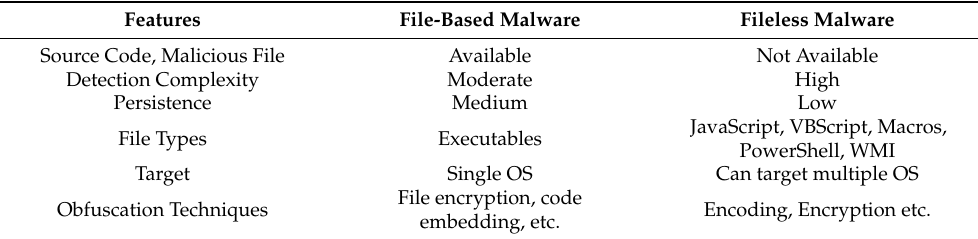
Table 2. Comparison between file-based and fileless